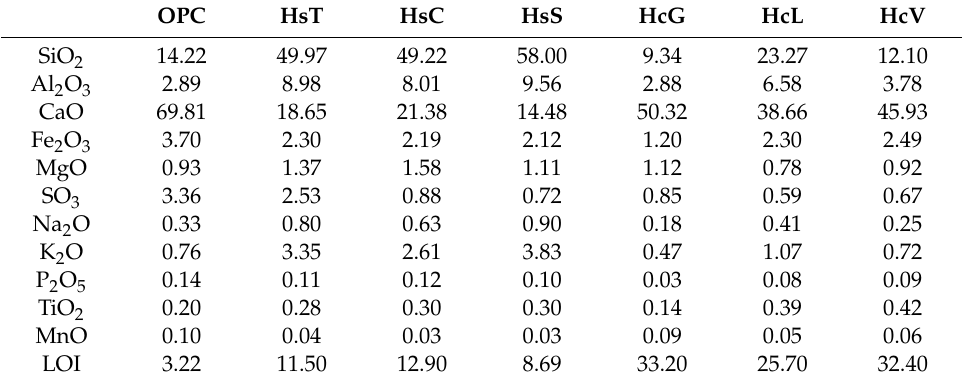
Table 1. X-Ray Fluorescence (XRF)-determined chemical composition of fine particle construction